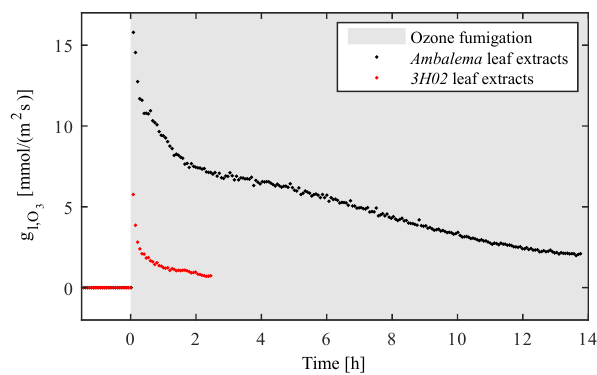
Figure 2. Ozonolysis experiments with pure leaf exudates extracted from non-ozone fumigated, unimpaired plants. The leaf extracts containing the surface compounds were applied to the inner surface of the empty plant enclosure system (see Sect. 2). During ozone fu- migation (grey shaded area), the total ozone conductance g l , O the enclosure surface was much higher for Ambalema leaf extracts (containing large amounts of the diterpenoid cis -abienol) than for 3H02 extracts. Moreover, it remained high for many